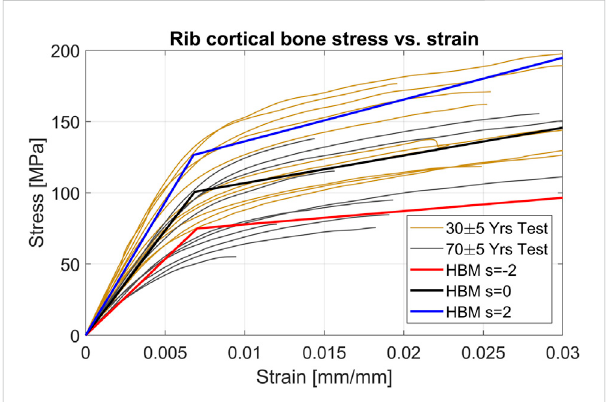
FIGURE 9 Individual test results from rib cortical bone tensile testing for younger (30 ± 5 years)and older (70 ± 5 years) subjects, togetherwith scaled HBM cortical bone material